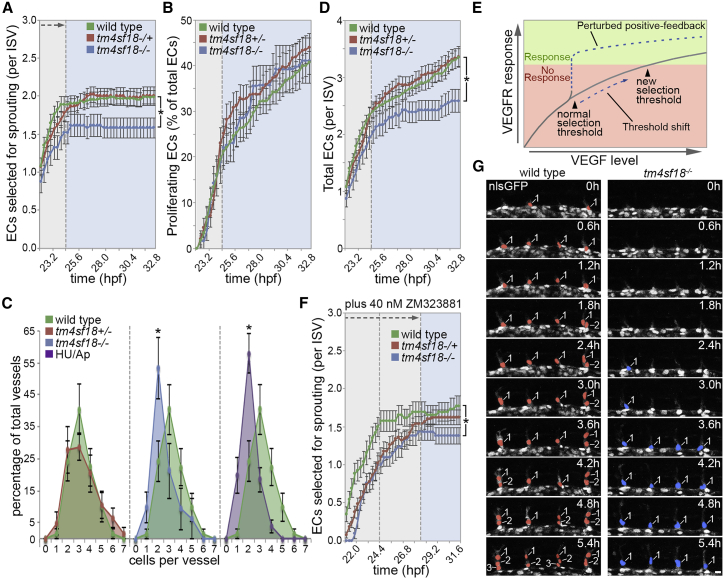
Tm4sf18 Modulates the Magnitude and Timing of the Angiogenic Response(A and B) Quantification of the number of ECs selected to branch (A) or the percentage of ECs that undergo proliferation (B) in WT, tm4sf18+/−, and tm4sf18−/− embryos (n = 62 ISVs from 16 WT, 58 ISVs from 15 tm4sf18+/−, and 31 ISVs from 8 tm4sf18−/− embryos).(C) Quantification of the distribution of ISV cellularity in WT, tm4sf18+/−, tm4sf18−/−, and HU/Ap-treated embryos (n = 65 ISVs from 16 WT, 62 ISVs from 15 tm4sf18+/−, 31 ISVs from 8 tm4sf18−/−, and 88 ISVs from 22 HU/Ap-treated embryos).(D) Quantification of the total number of ECs per ISV in WT, tm4sf18+/−, and tm4sf18−/− embryos. n is the same as in (A).(E) Predicted shift in the level of VEGF signaling required to achieve a selection threshold in the absence of positive feedback.(F and G) Quantification of the number of ECs selected to branch in 40 nM ZM323881-treated WT, tm4sf18+/− and tm4sf18−/− embryos (F) and corresponding time-lapse images of sprouting ISVs in 40 nM ZM323881-treated WT and tm4sf18−/− embryos from 20 hpf (G). Embryos were incubated with 40 nM ZM323881 from 18 hpf onward. Nuclei of sprouting ECs emerging from the DA are pseudocolored (n = 26 ISVs from 10 WT, 50 ISVs from 20 tm4sf18+/−, and 21 ISVs from 10 tm4sf18−/− embryos).Data are means ± SEM. ∗p < 0.05, two-way ANOVA or two-tailed t test. Scale bar, 25 μm.See also Figure S3.